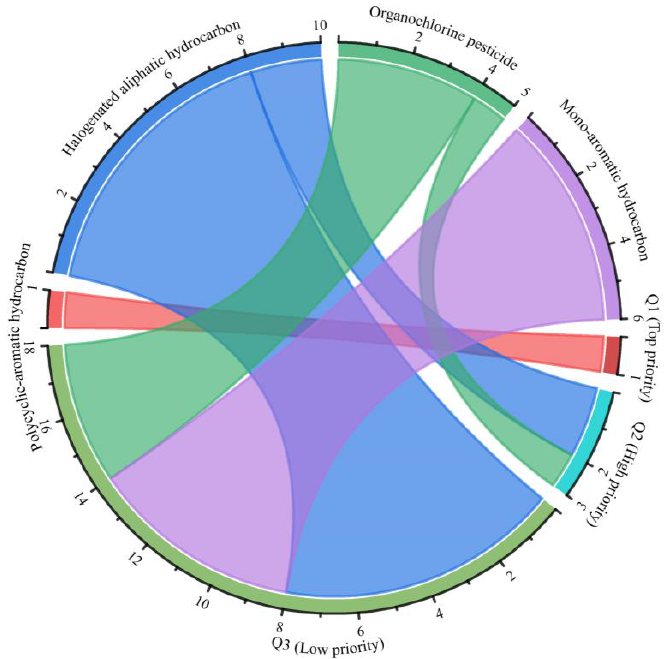
Figure 4. Proportion and quantity of priority levels for various categories of groundwater organic pollutants.